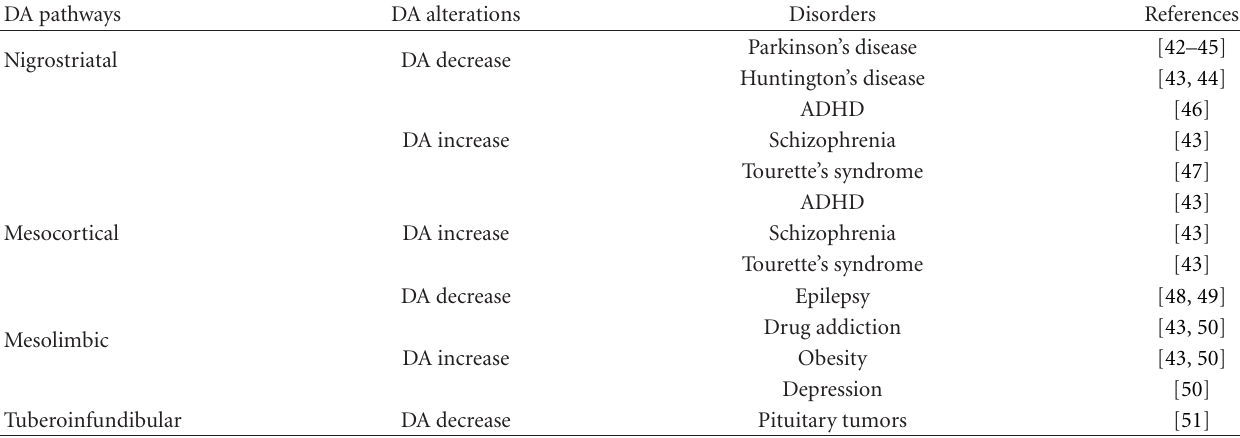
Table 2: Modulation of dopaminergic pathways and their associated changes of dopamine levels in neurological disorders. DA